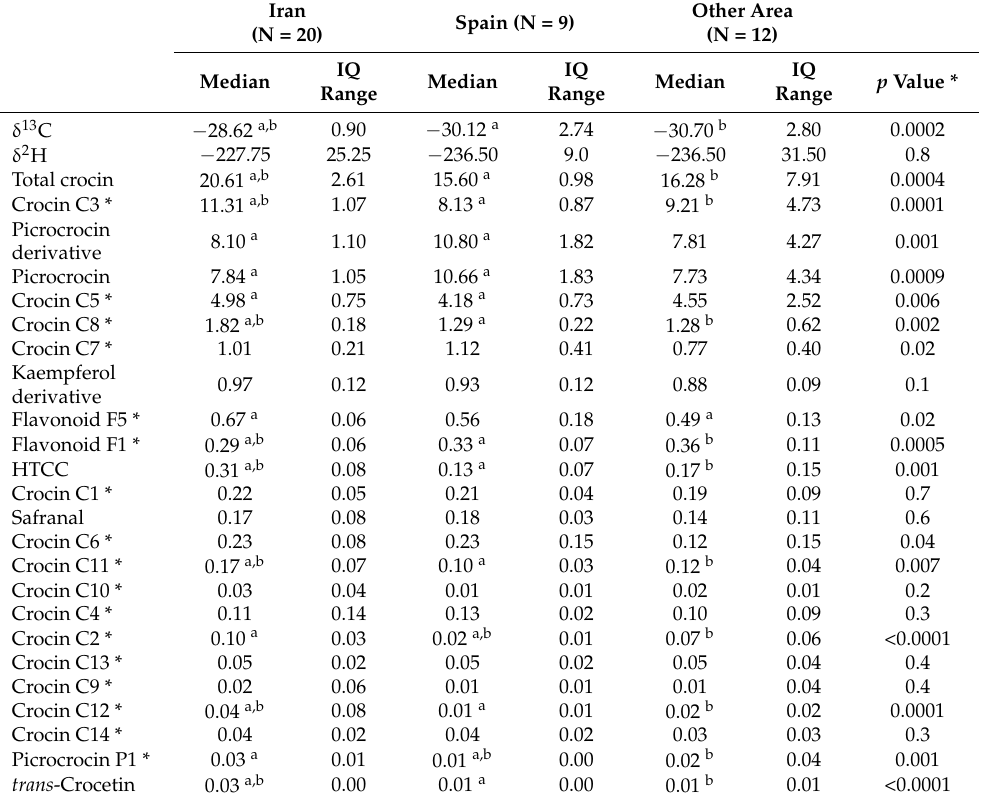
Table 2. Comparison of safranal isotope ratios (‰) and saffron metabolites (% w / w ) included in saffron samples according to geographical origins (N =